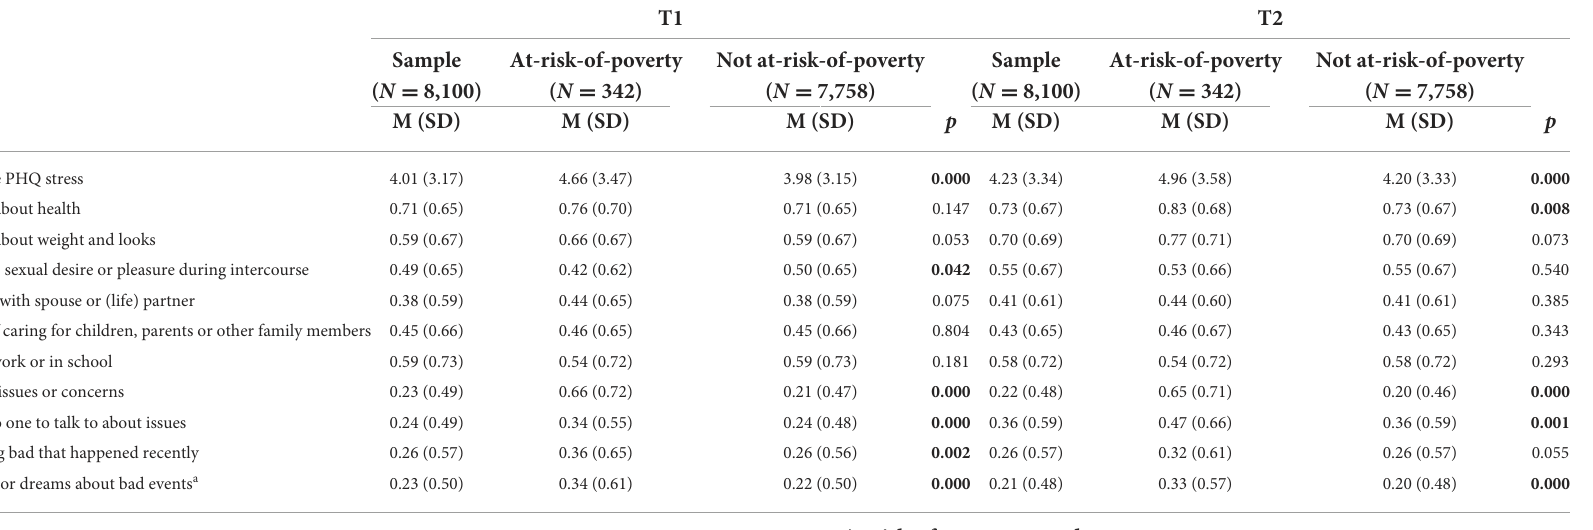
TABLE 3 Stressors and burdens of men and women living and not living at-risk-of-poverty ( N =